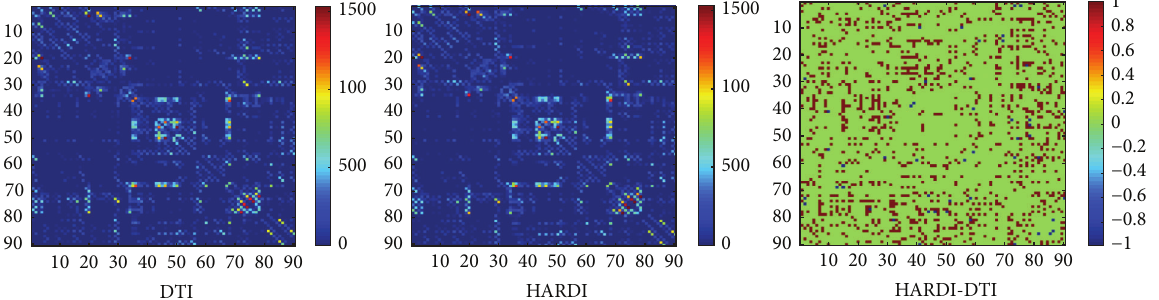
Figure 3: The 90 × 90 connectivity matrices built with the DTI method and the HARDI method, respectively. The right panel shows the binary difference between the left two matrices for a selected subject, where the entries with +1 denote connections detected by HARDI but not DTI, and − 1 for connections detected by DTI but not